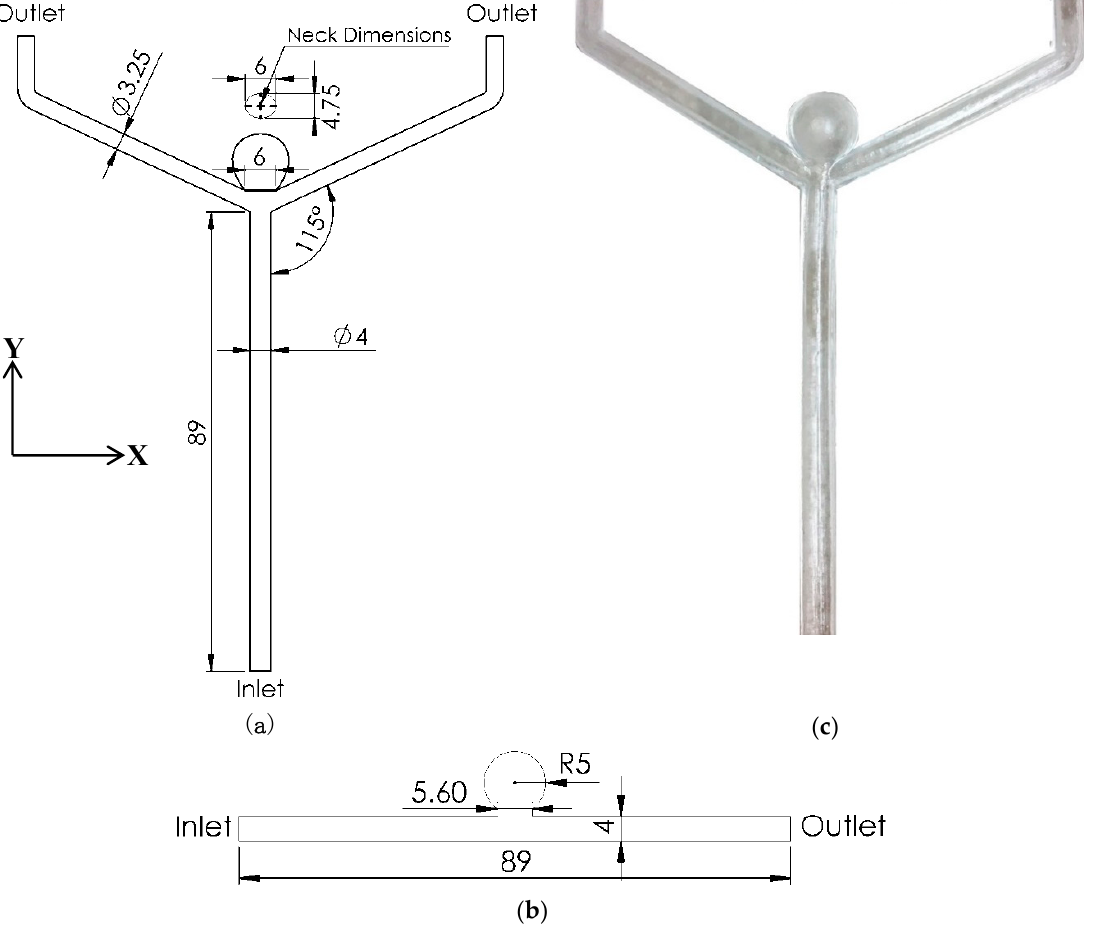
Figure 1. ( a ) Bifurcation aneurysm model drawing, ( b ) sidewall model drawing, and ( c ) sample image of the manufactured silicone model; length units are in